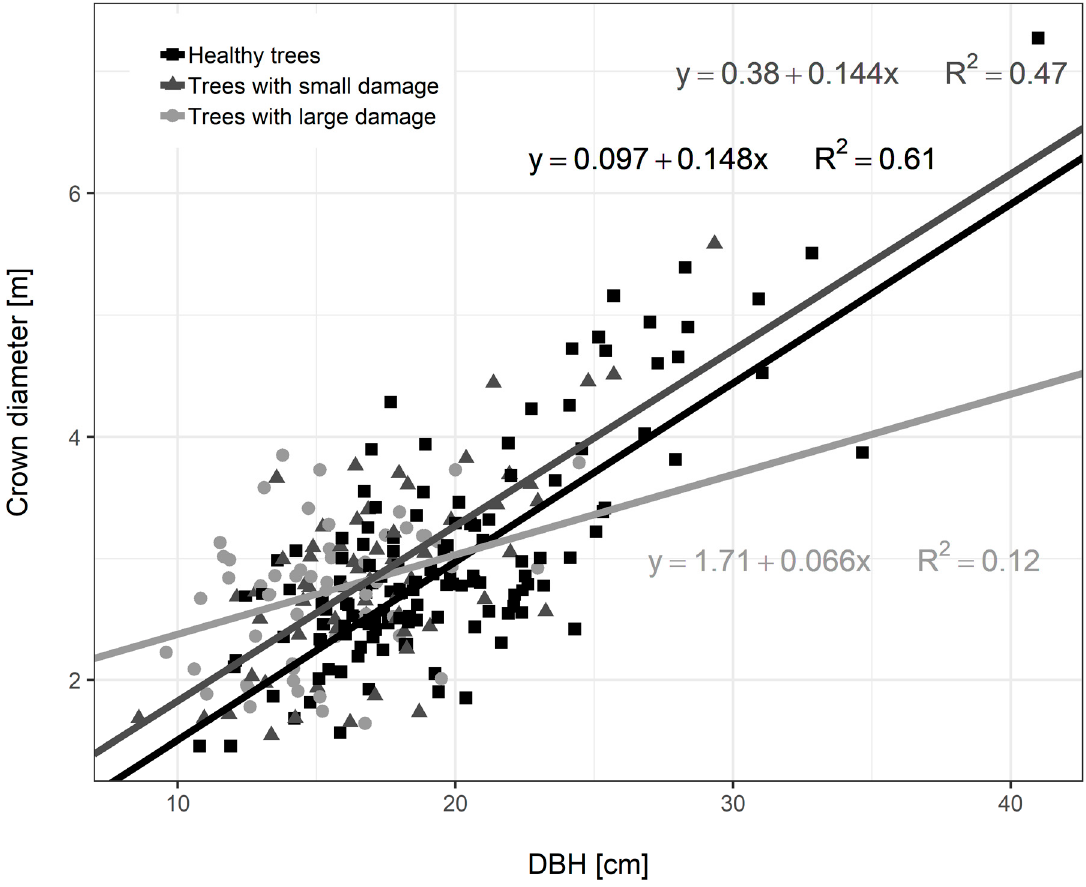
Figure 3. The relationship between crown diameter and DBH for healthy trees and trees with high damage. The bold lines represent linear regression functions (presented in relevant color).